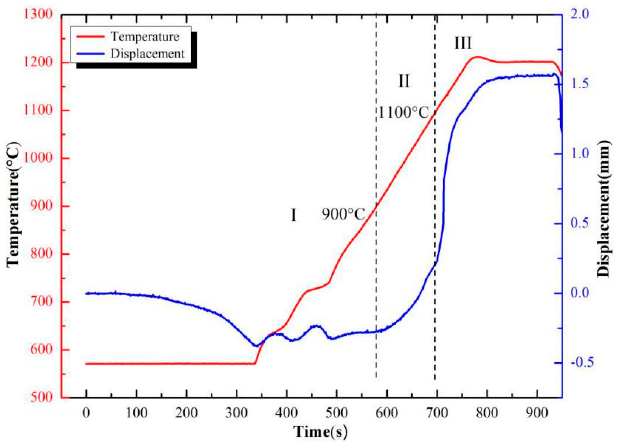
Figure 2. Curves of temperature and displacement vs. time in sintering process.